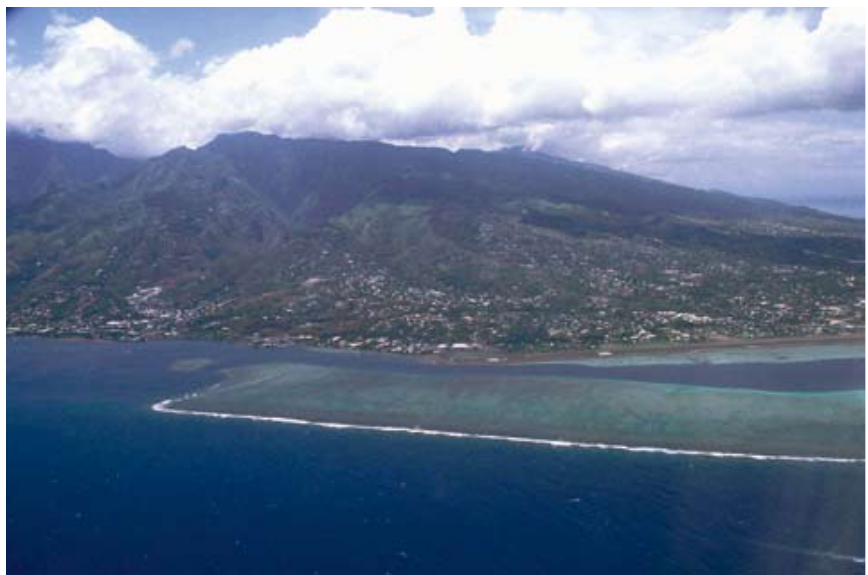
Figure 6. A potential drilling site of IODP Expedition 310 offshore Papeete (Tahiti).